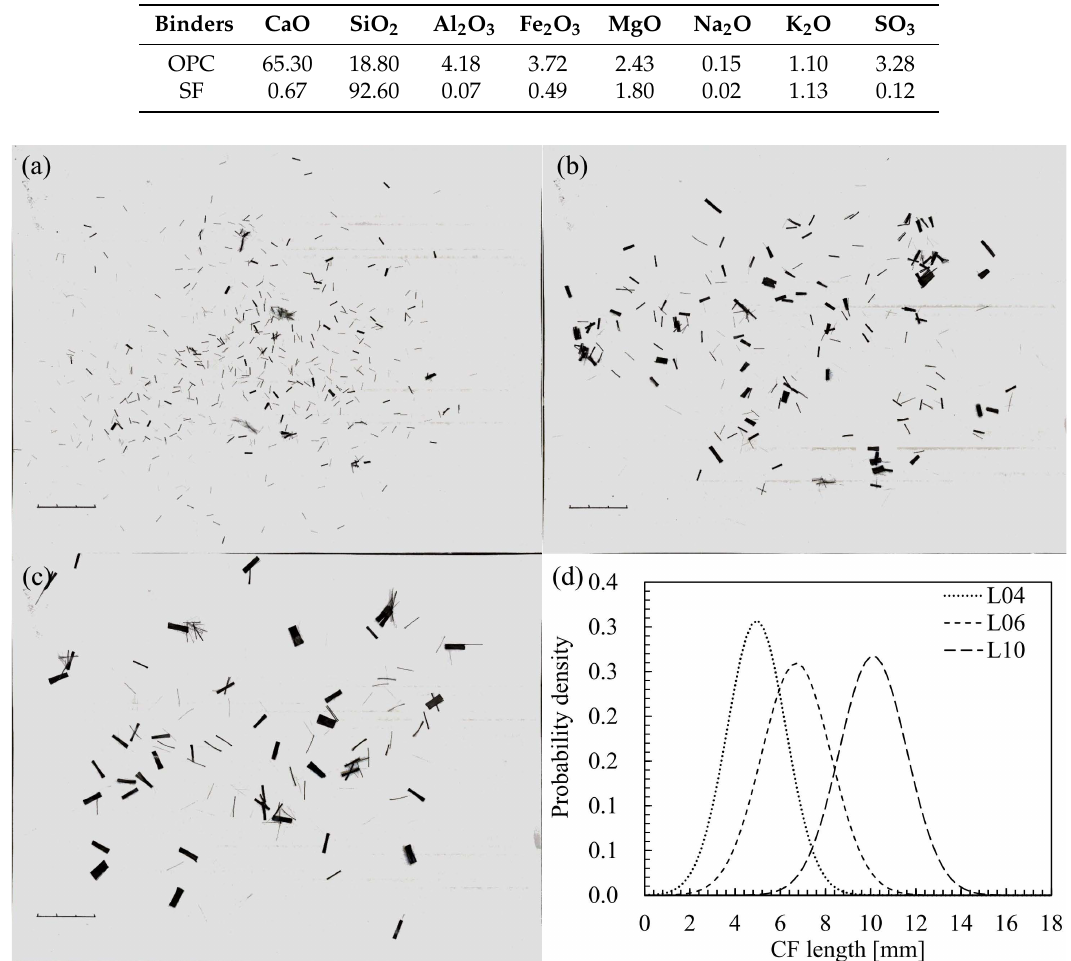
Table 1. Chemical compositions of ordinary Portland cement (OPC) and silica fume (SF).